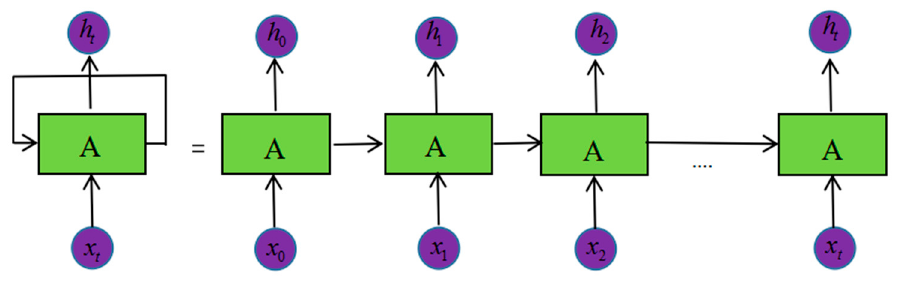
Figure 12. RNN network structure.